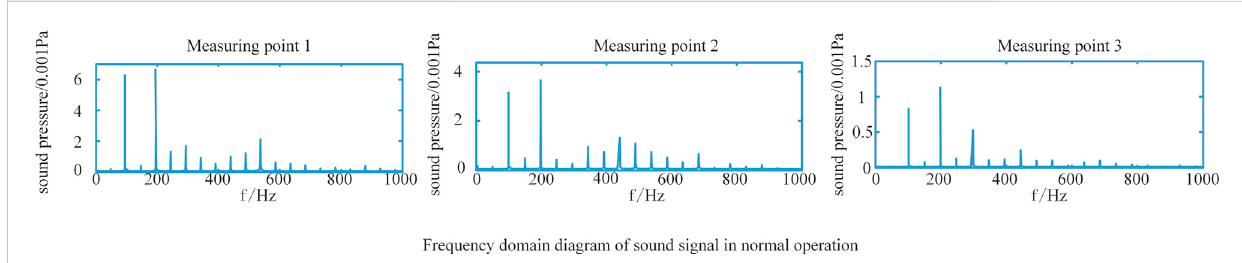
FIGURE 2 Frequency distribution of acoustic signal in normal operation of transformer winding.